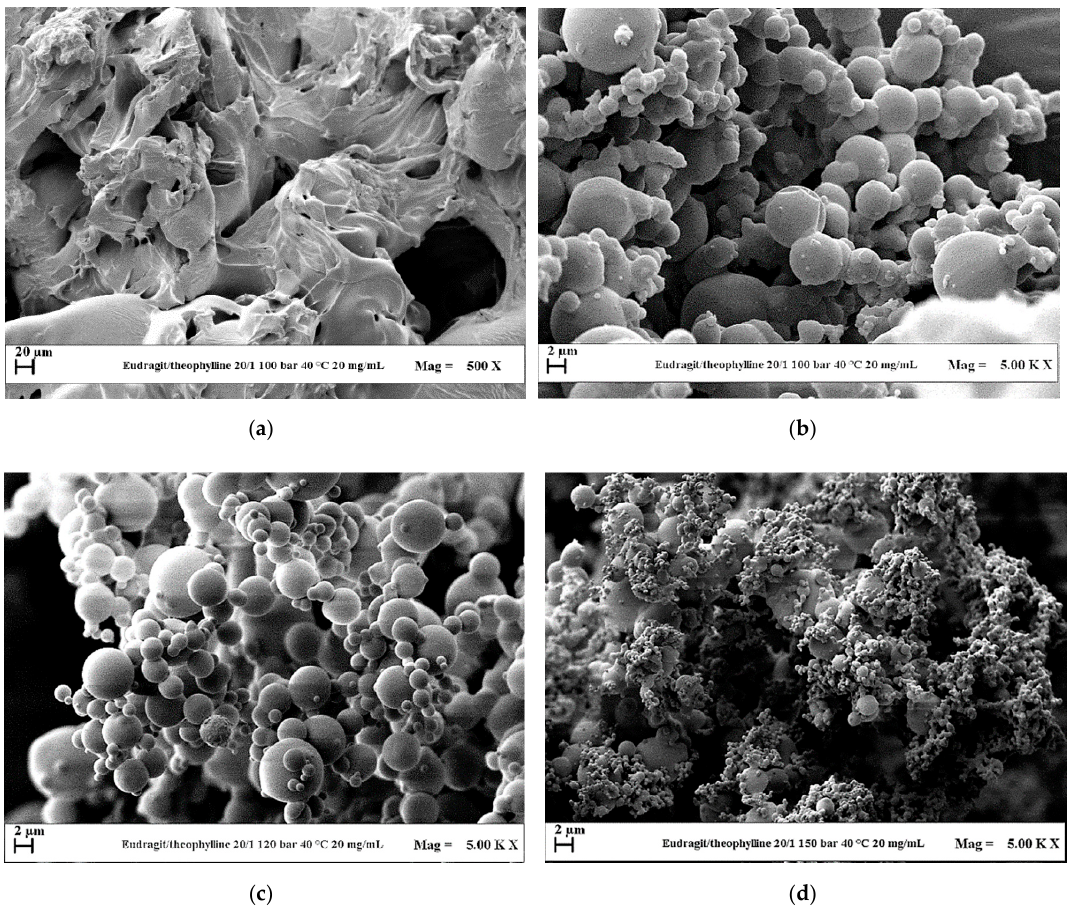
Figure 6. FESEM images of EUD/THEOP 20/1 powders precipitated from DMSO at 40 °C and 20 mg/mL. Effect of the operating pressure. ( a ) 10 MPa (run #13) filter; ( b ) 10 MPa (run #13) precipitating chamber; ( c ) 12 MPa (run #14); ( d ) 15 MPa (run #15).